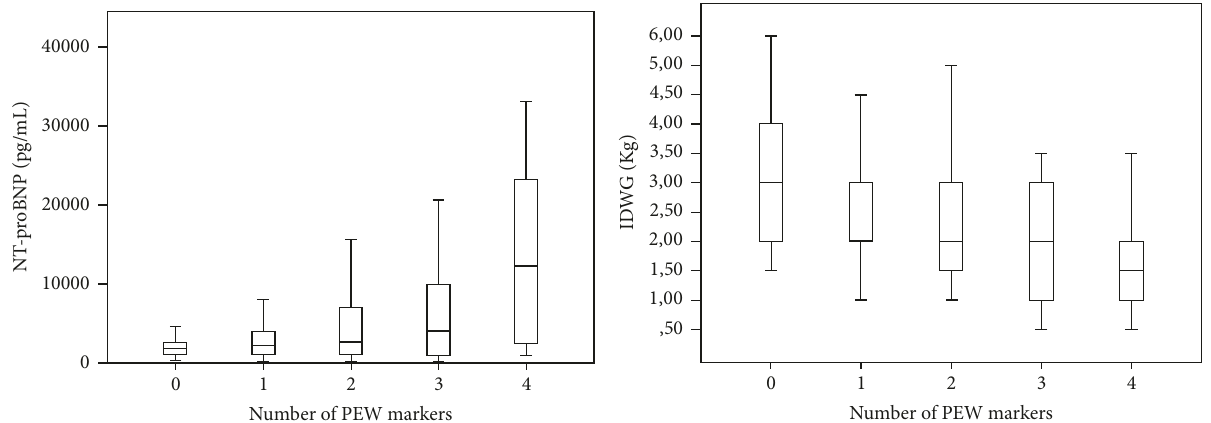
Figure 1: Distribution of NT-proBNP levels ( 𝑃 < 0.001 ) and IDWG ( 𝑃 < 0.001 ) according to the number of malnutrition criteria.